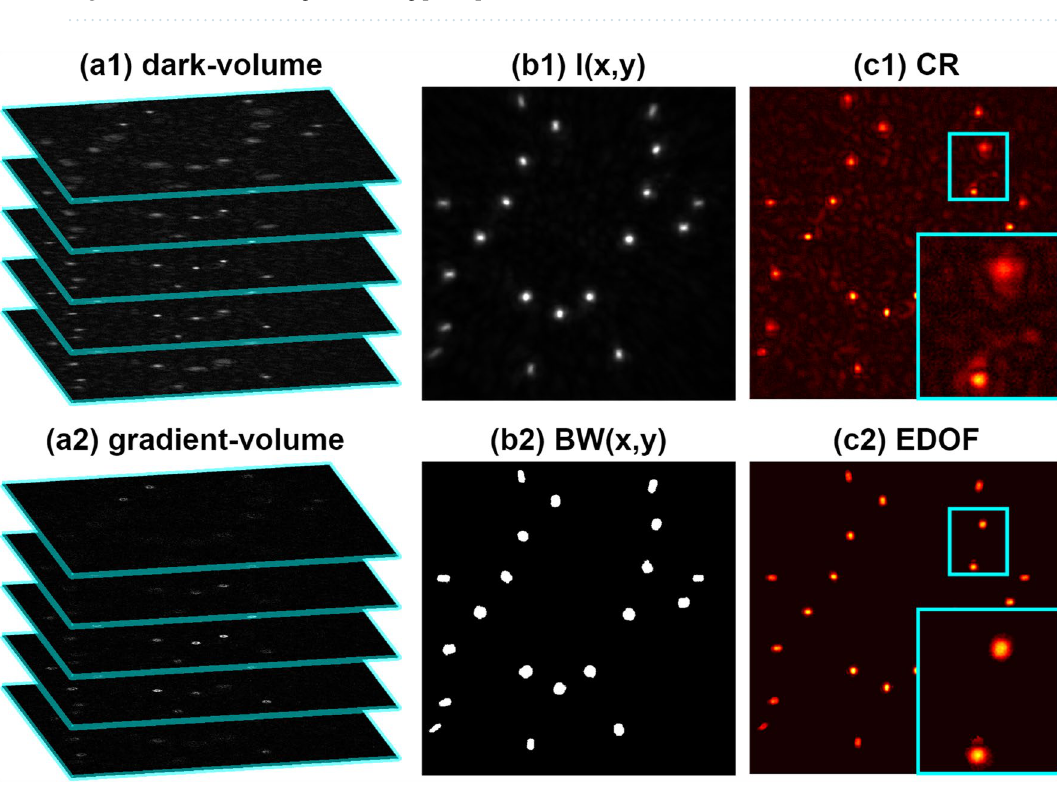
Figure 2. DarkTrack single-hologram (as shown in Fig. 1c2) processing